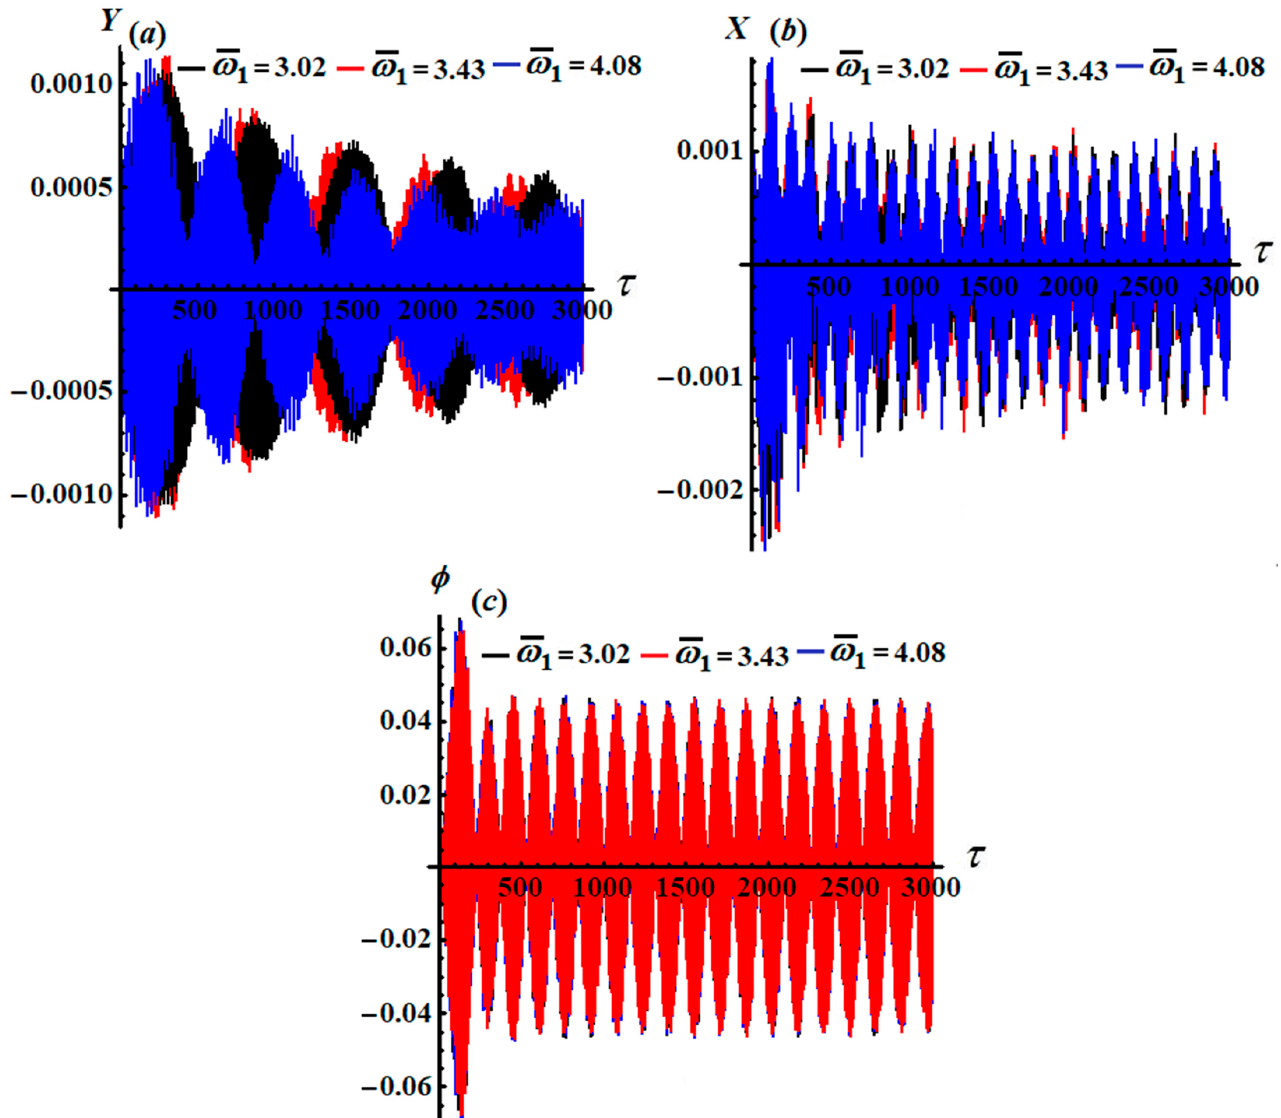
φ τ with time : ( a – c ) when